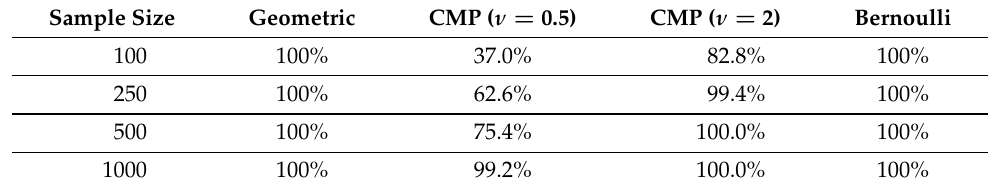
Table 3. Power of the likelihood ratio test (at 5% level) when data are generated from the trivariate geometric, the trivariate CMP with ν = 0.5, the trivariate CMP with ν = 2 and the trivariate Bernoulli, respectively, for various sample sizes, {100, 250, 500,